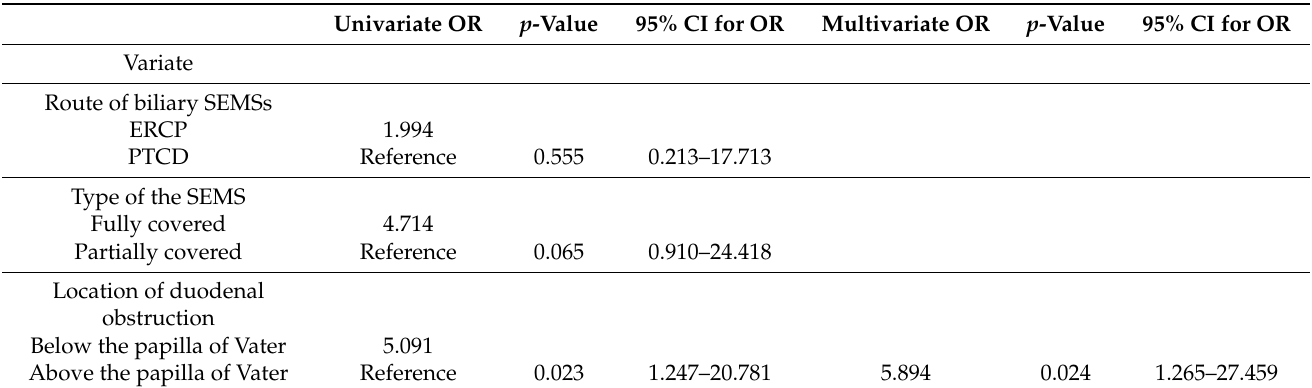
Figure 2. Kaplan–Meier curve showing time to duodenobiliary reflux (DBR)-related covered biliary self-expandable metal stents (SEMS) dysfunction according to gastric outlet obstruction scoring system (GOOSS) after treatment for duodenal obstruction. 4. Discussion Synchronous malignant bilioduodenal obstruction is a challenging clinical scenario and a severe co-morbidity, usually caused by different malignancies such as advanced local tumors, including pancreatic cancer, bile duct cancer, or metastases that involve the